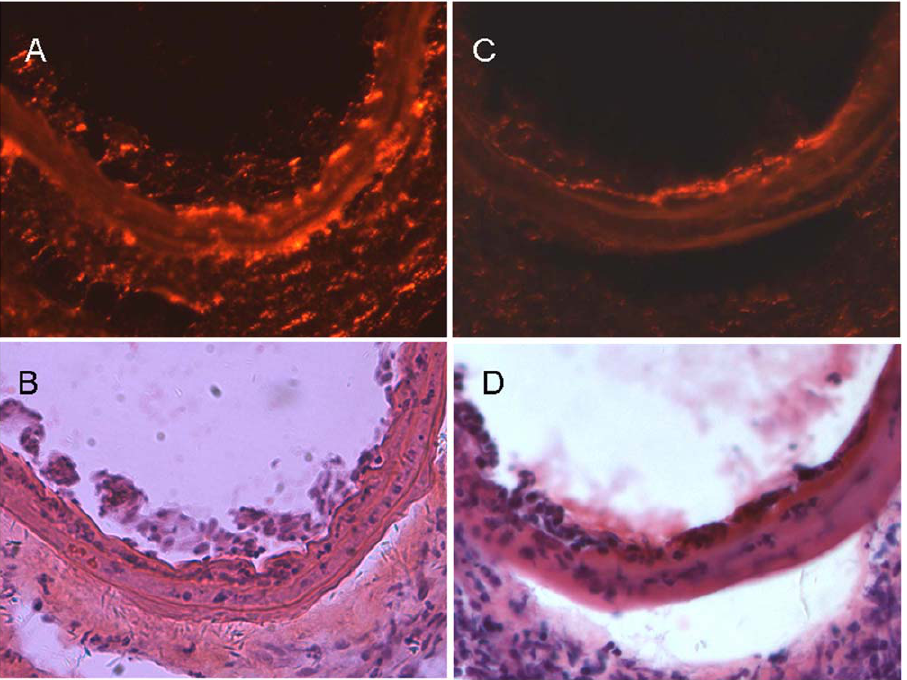
Figure 6. Transfused EPCs contribute to reendothelialization. Laser scanning confocal microscopic analysis (6A, 6C) and H&E staining (6B, 6D) demonstrated accumulation of transfused Dil-Ac-LDL-labeled EPCs at the injury site 5 days (6A, 6B) and 10 days (6C, 6D) after endothelium damage of LCCA. (Magnification 6 200).